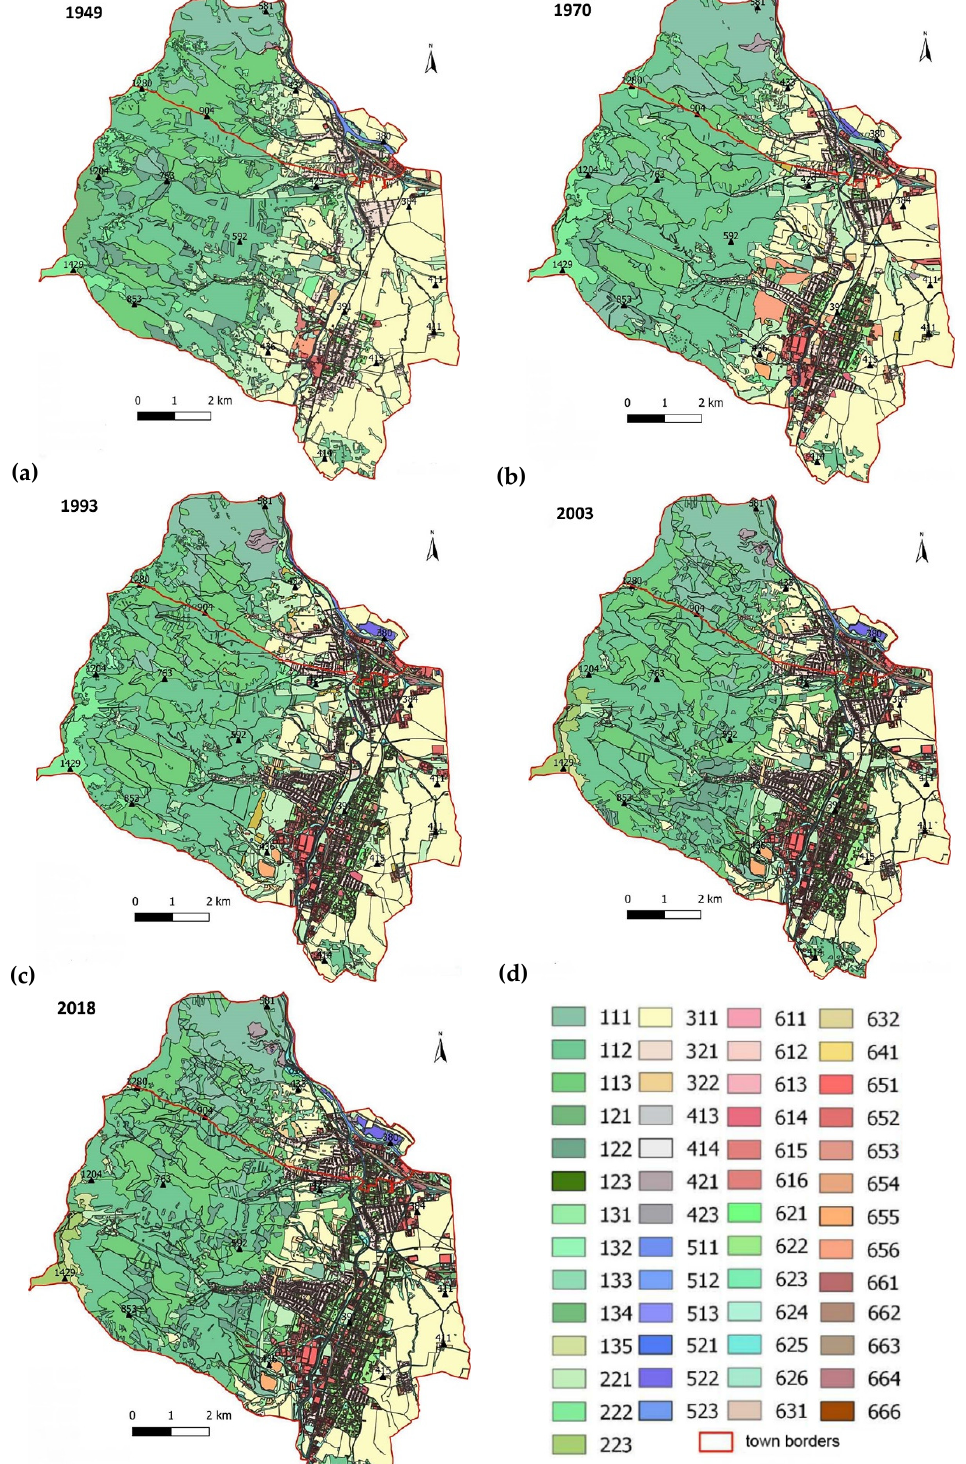
Figure A1. The landscape structure in 1949, 1970, 1993, 2003, and 2018 ( a–e ).